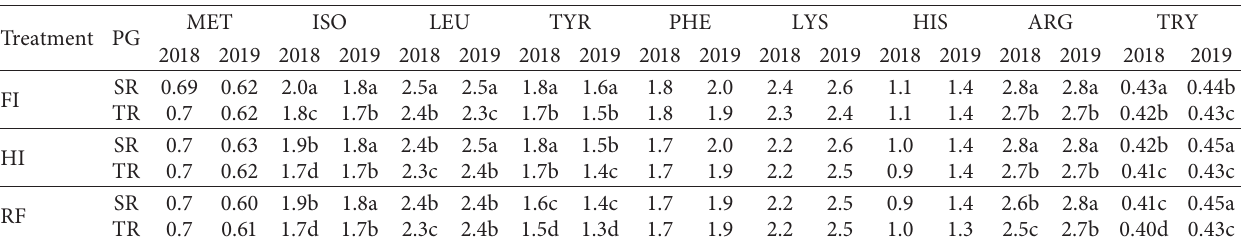
Table 7: Effect of irrigation treatments (FI, HI, and RF) and PG (SR and TR planting) on soybean seed amino acids: methionine (MET), isoleucine (ISO), leucine (LEU), tyrosine (TYR), phenylalanine (PHE), lysine (LYS), histidine (HIS), arginine (ARG), and tryptophan (TRY)